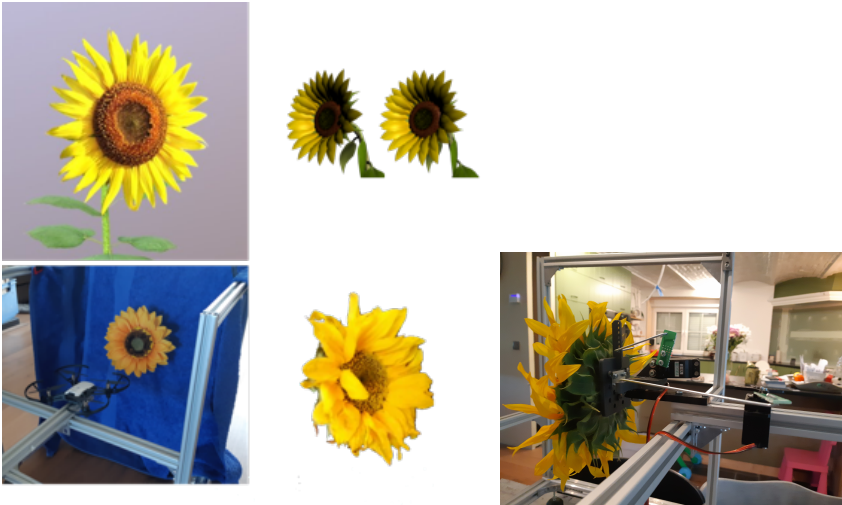
Figure 6. Acquisition of the training data. Top: 3D models of flowers are rendered at different angles and positions. Bottom: our chroma key set-up that is used to acquire images from both artificial ( left ) and real ( center ) sunflowers, with the drone’s camera, using a 2 DoF rotator device ( right